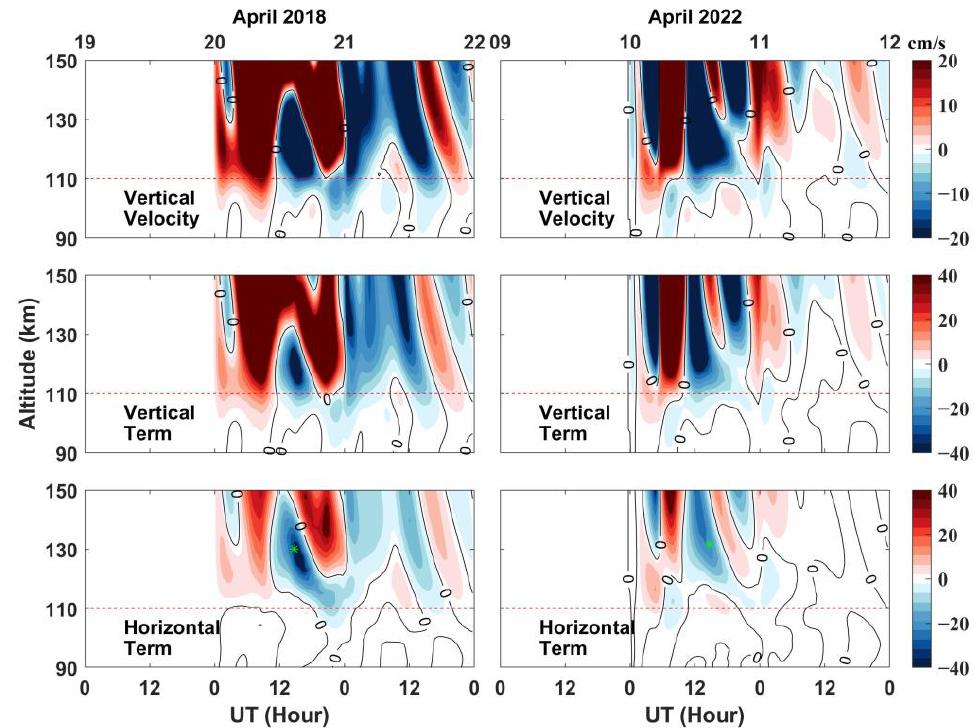
Figure 4. Storm-time differences (rkp − ckp) in vertical velocity, vertical term, and horizontal term at the location of (78.75 °S, 60 °E) in the altitude ranges of 90 km to 150 km in the two storms. The vertical velocity was the sum of the vertical term and horizontal term. The red dashed lines represent 110 km. The black lines represent the zero value. The green asterisks corresponded to the time and altitude of 14:20 UT and ~130 km, respectively.